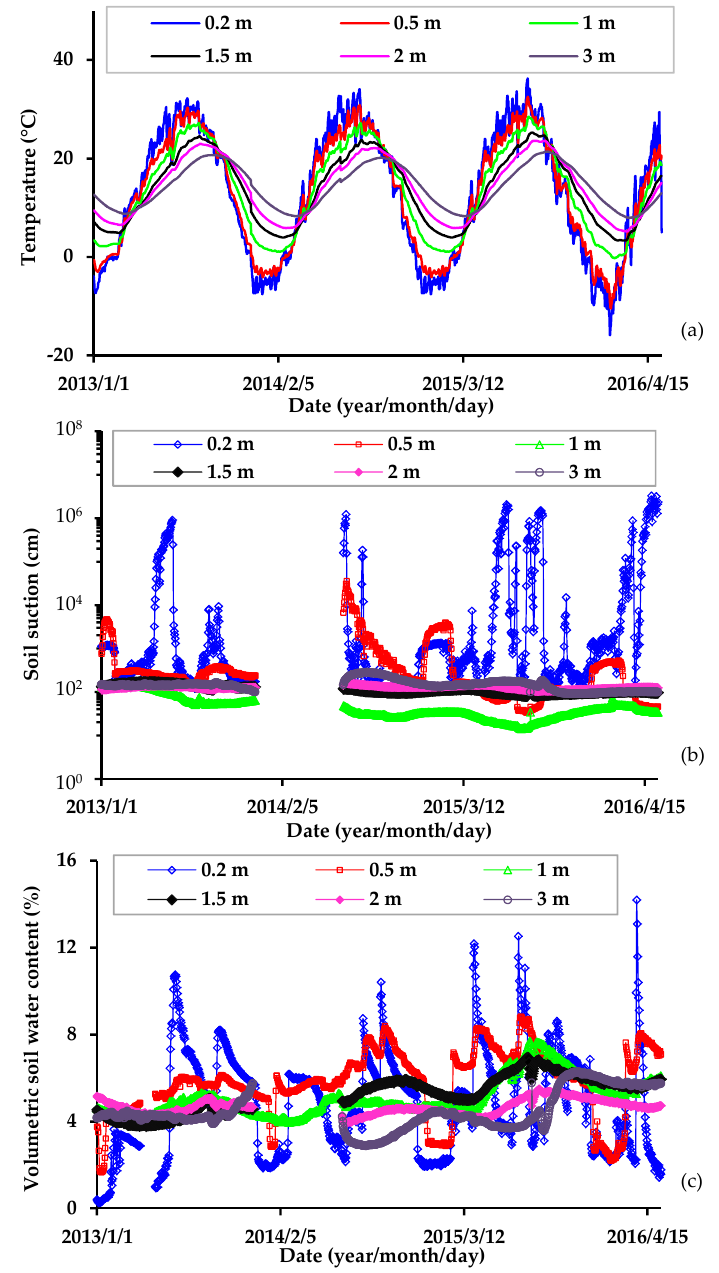
Figure 3. Daily data during the 2013–2016 period with respect to various depths (0.2 to 3.0 m) at the soil monitoring station in the Badain Jaran Desert (BJD): ( a ) Temperature; ( b ) soil matrix suction; and ( c ) volumetric soil water content.